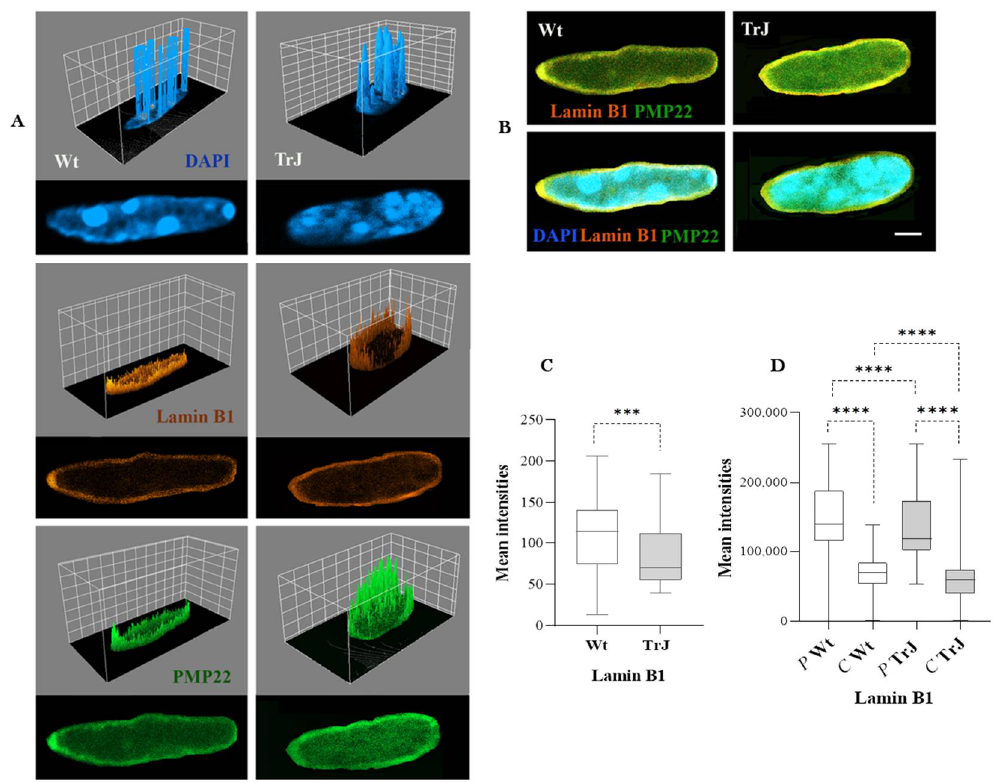
Figure 4. Lamin B1 intensity, peripheral versus central Lamin B1 distribution, and its relationship to PMP22 in Wt and TrJ Schwann cell nuclei. ( A ): 3D surface plot illustrating the intensity of DAPI, Lamin B1, and PMP22 signal (arbitrary units) distributions upon a central plane of each Wt or TrJ SC nucleus. The peaks correspond to nuclear regions of the greatest intensity. The confocal images of Wt and TrJ Sc nuclei are presented below each corresponding 3D plot. ( B ): Merge images of Lamin B1 and PMP22 or DAPI, Lamin B1 and PMP22. ( C , D ): Box plot showing Lamin B1 intensities and its peripheral (P) versus central (C) distribution in Wt and TrJ SC nuclei, respectively. Median and 25% and 75% quartiles are represented in each box. Differences between peripheral versus central distribution in Wt and TrJ were verified by applying Mann–Whitney tests ( p -values: *** < 0.001, **** < 0.0001) in 100 SC nuclei per analysis and genotype. Scale bar = 2µm. Lamin B1 fluoresces less